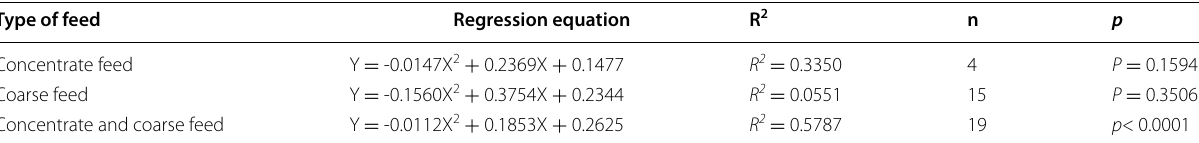
Table 4 Regression analysis between the content of CP in feedstuffs after 16 h of incubation in the rumen and after intestinal digestion